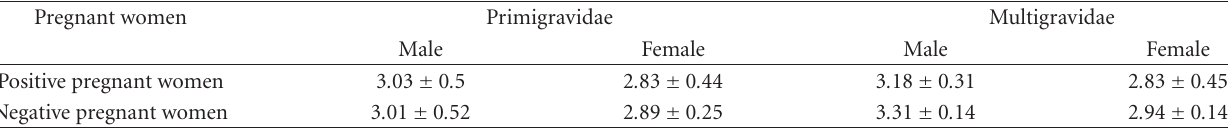
Table 4: Mean ( ± SD) birthweights (kg) of neonate of pregnant women at General Hospital Minna, North Central